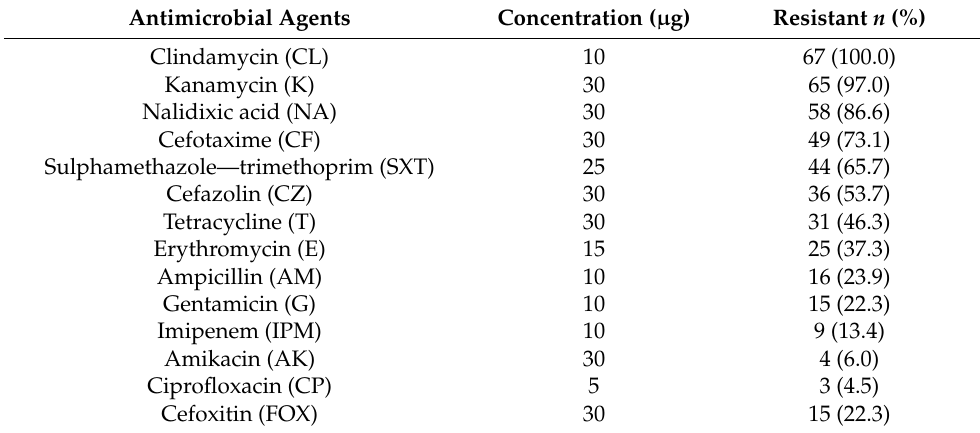
Table 4. Antimicrobial resistance profile of S. aureus isolates ( n = 67) from animals, environment and Karish